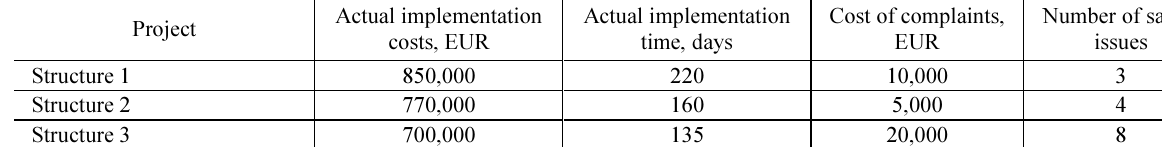
Table 2. Project results